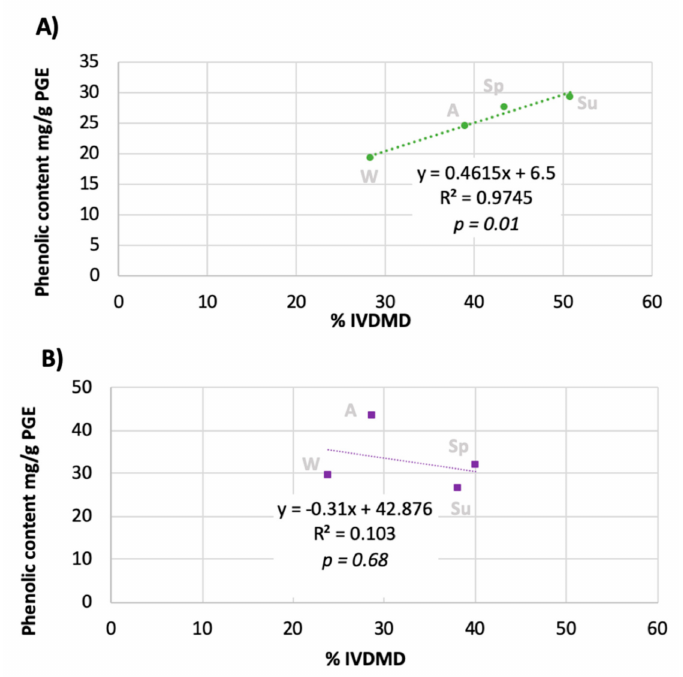
Figure 1. Correlation of phenolic content in phloroglucinol equivalents mg / g (DM) to in vitro digestibility of dry matter (%IVDMD) for A. nodosum ( A ) and F. serratus ( B